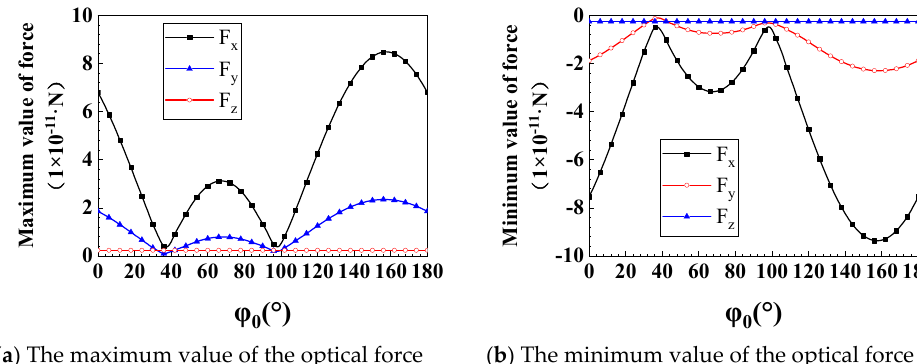
( a ) The maximum value of the optical force ( b ) The minimum value of the optical force Figure 8. The maximum and minimum values of optical force varies with ϕ 0 . ( a , b ) show the change Figure 8. The maximum and minimum values of optical force varies with 0 rules of the maximum and minimum values of F x , F y , and F z in the process of ϕ 0 increasing from 0 ◦ change rules of the maximum and minimum values of x to 180 ◦ ° ° to 180 . increasing from 0